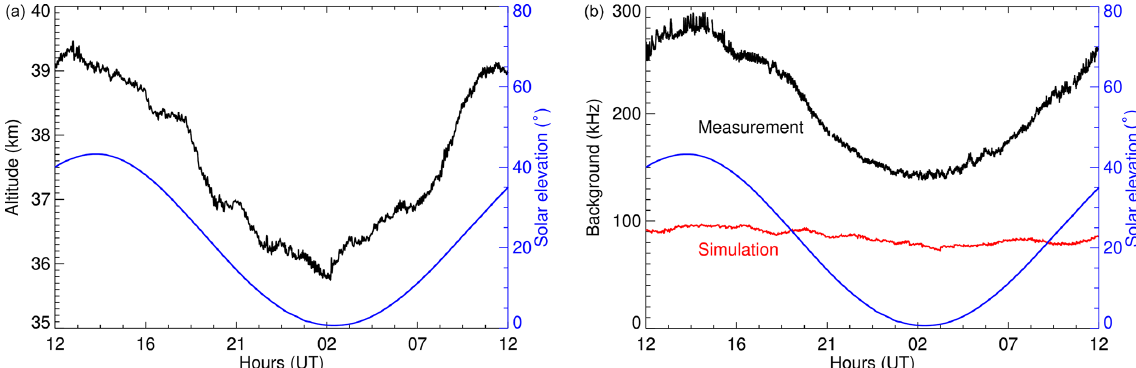
Figure 6. GPS altitude of the gondola (a) and measured and simulated lidar background (b) between the evening of 10 July and morning of 11 July 2018. The simulation (red line) includes the actual altitudes and solar elevation angles.